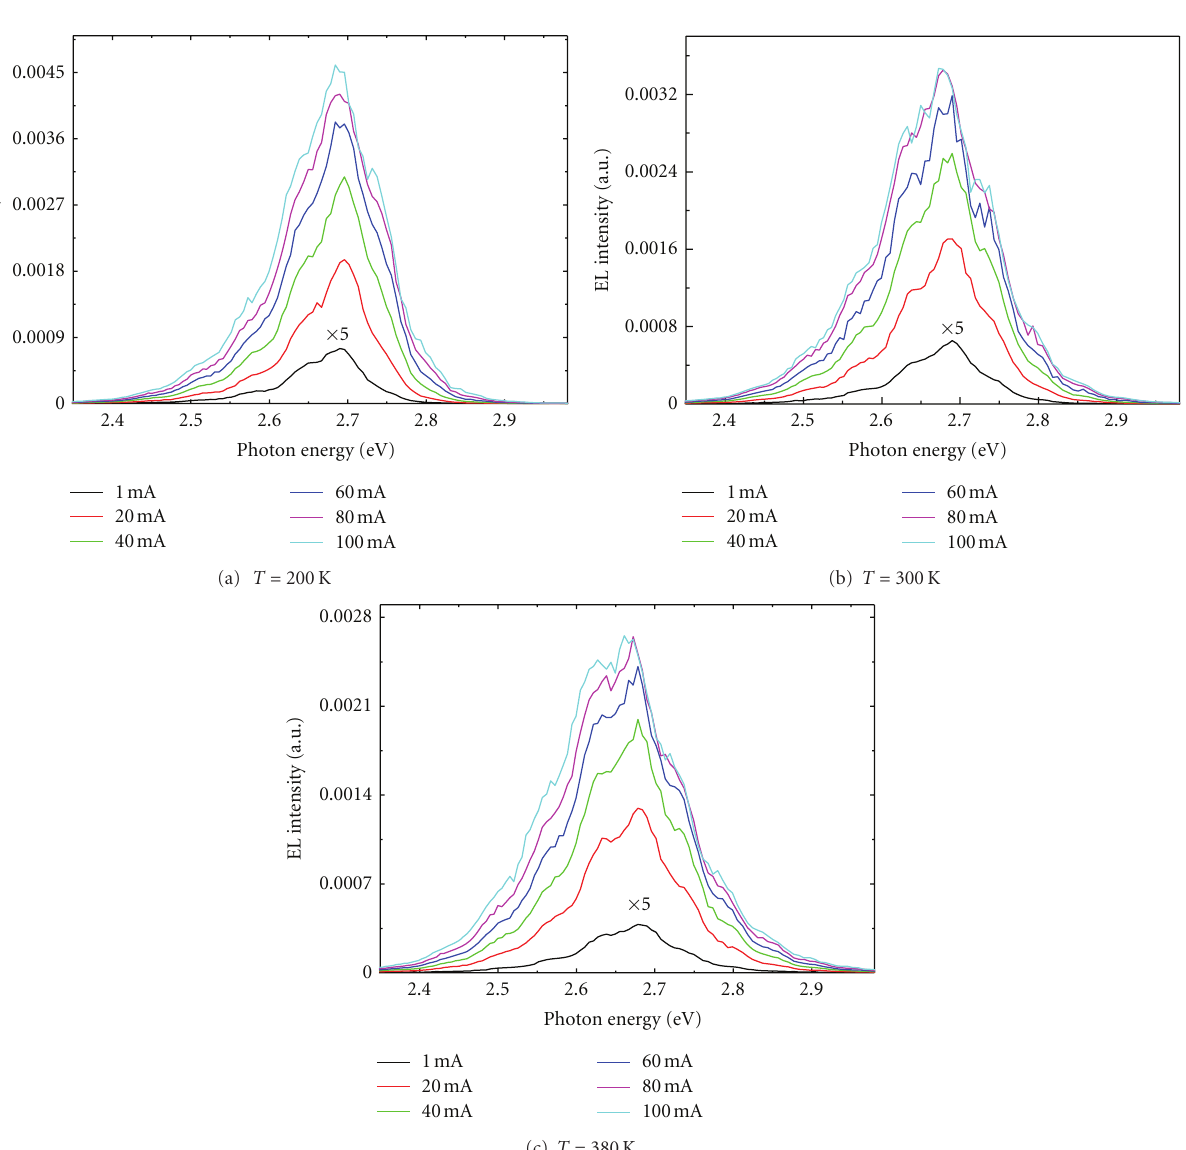
Figure 4: The EL spectra of sample with GaN barriers in the driving currents range from 1 to 100mA at temperature (a) 200 K, (b) 300 K, and (c) 380